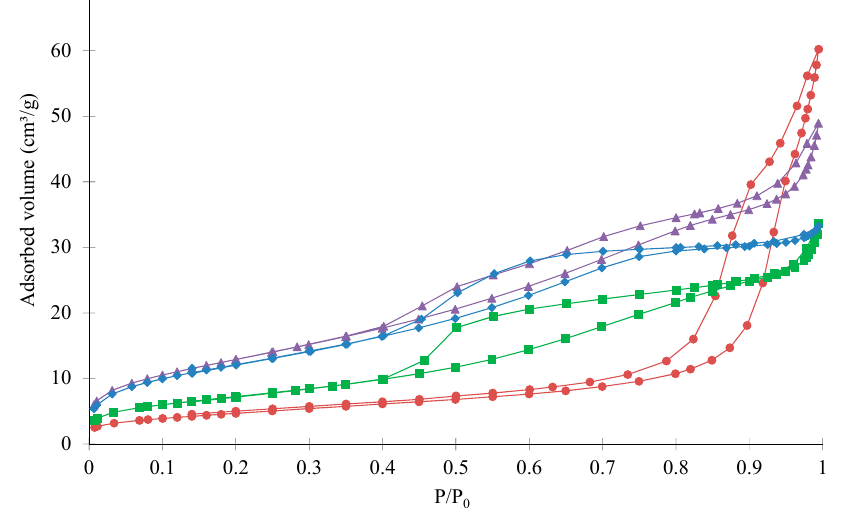
Figure2. Nitrogenadsorption-desorptionisothermsofsamples: ( (cid:8) )pureZnCo 2 O 4 ,( (cid:4) )ZnCo 2 O 4 / SnO 2 -10%, Figure 2. Nitrogen adsorption-desorption isotherms of samples: ( ● ) pure ZnCo 2 O 4 , ( ■ ) ZnCo 2 O 4 /SnO 2 - ( (cid:78) ) ZnCo 2 O 4 / SnO 2 -20% and ( (cid:7) ) ZnCo 2 O 4 / SnO 2 10%, ( ▲ ) ZnCo 2 O 4 /SnO 2 -20% and ( ♦ ) ZnCo 2 O 4 /SnO 2 -30%.